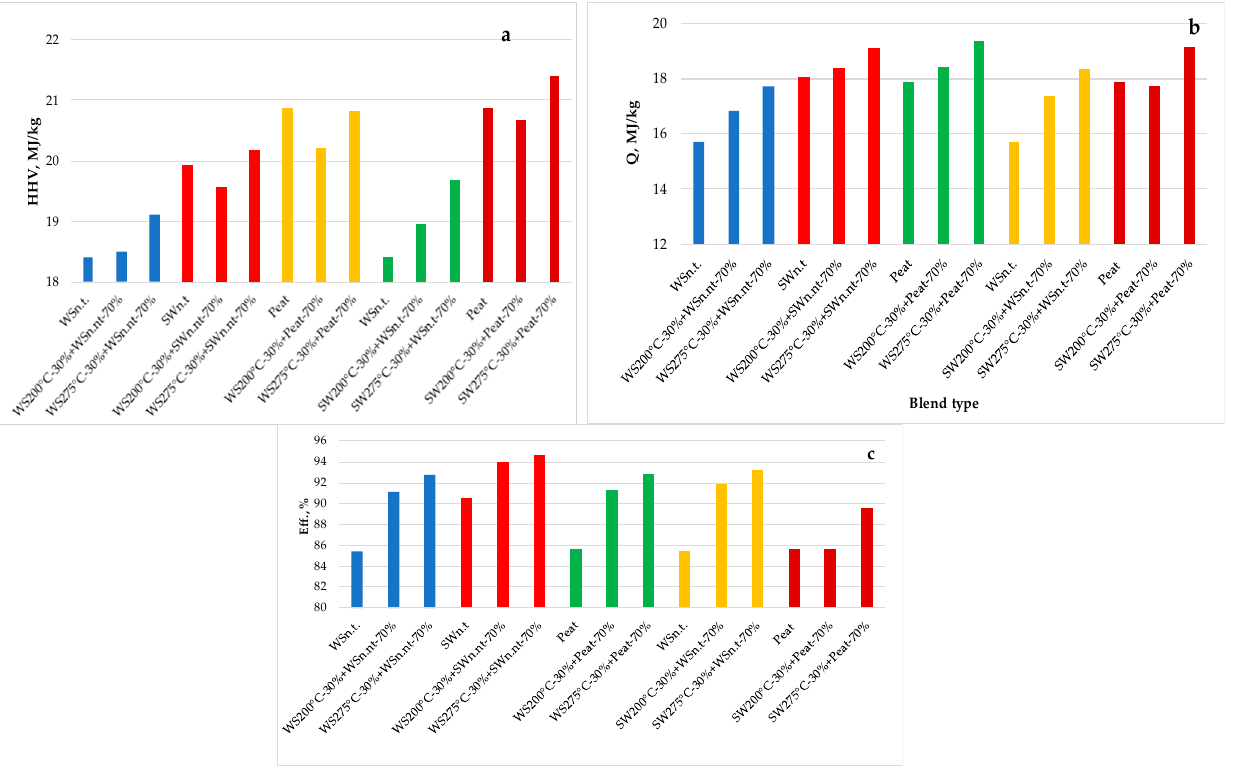
Figure 5. Influence of temperature values at MW pre-treatment of wheat straw and softwood pellets presented in binary blends on their heating values ( a ) the yield of heat energy at furnace combustion ( b ) and process efficiency ( c ). Binary blends consisting of non-treated and pre-treated wheat straw, non-treated softwood and pre-treated wheat straw, non-treated peat and pre-treated wheat straw, non-treated wheat straw and pre-treated softwood, non-treated peat and pre-treated softwood are in blue, rich red, green, yellow, red-brown colors correspondingly.